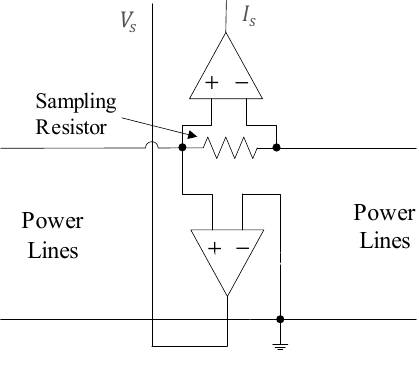
Figure 6. The block diagram of voltage and current measurement circuit [78].